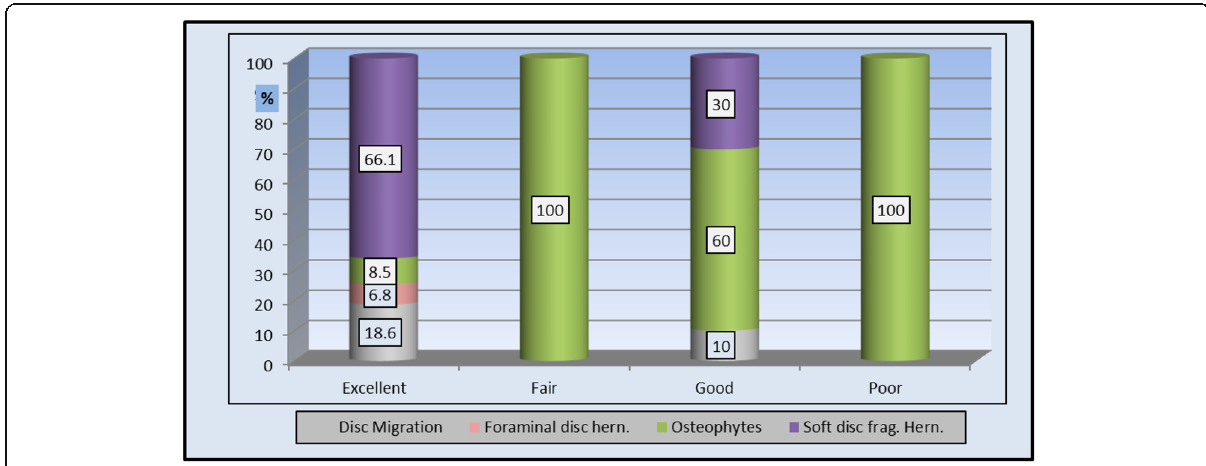
Fig. 6 Odom ’ s category in relation to offending